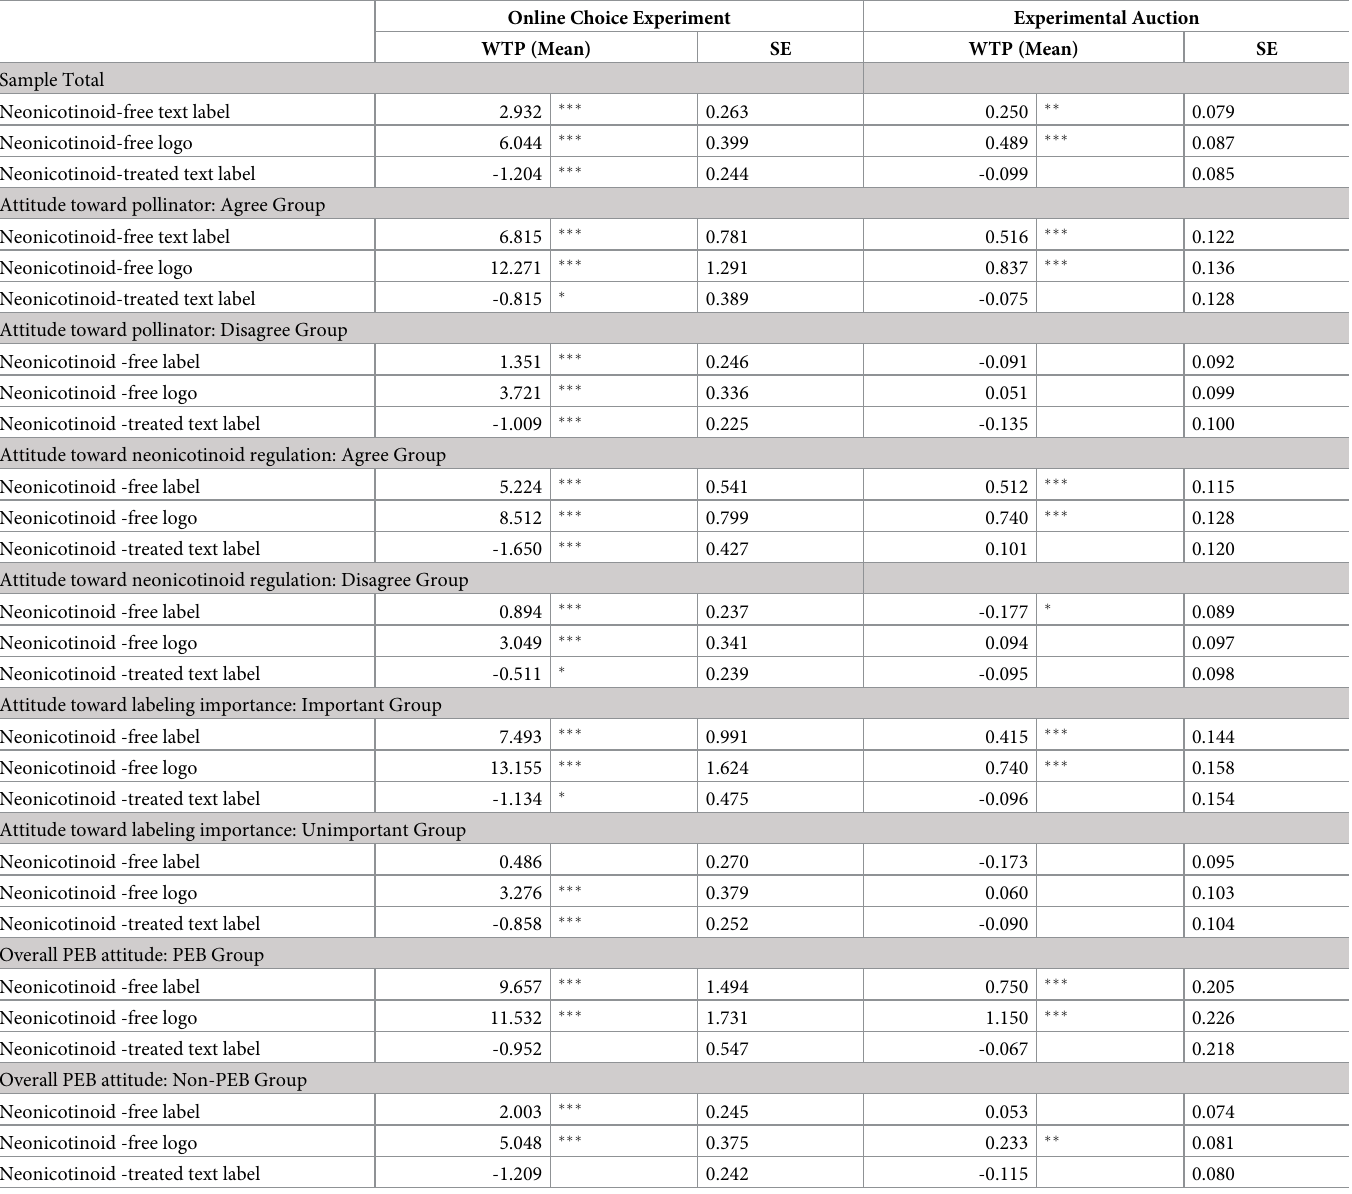
Table 6. Willingness-to-pay estimates for important product attributes, by dichotomous